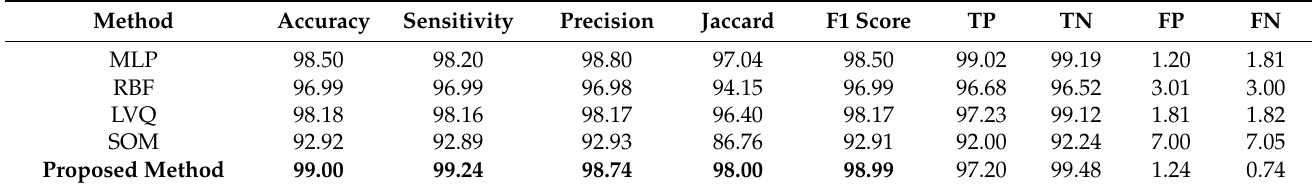
Table 3. Accuracy, sensitivity, precision, Jaccard, and F1 score of the proposed